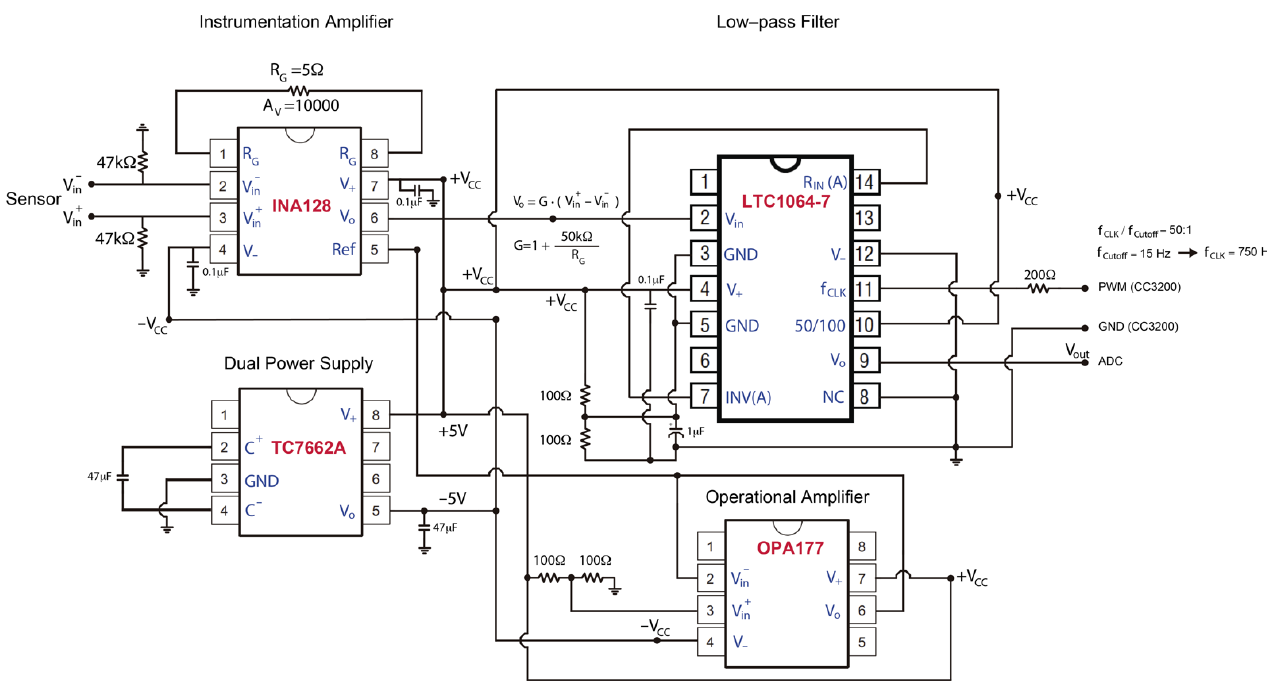
Figure 2. Electronic schematic of the signal conditioning circuit.